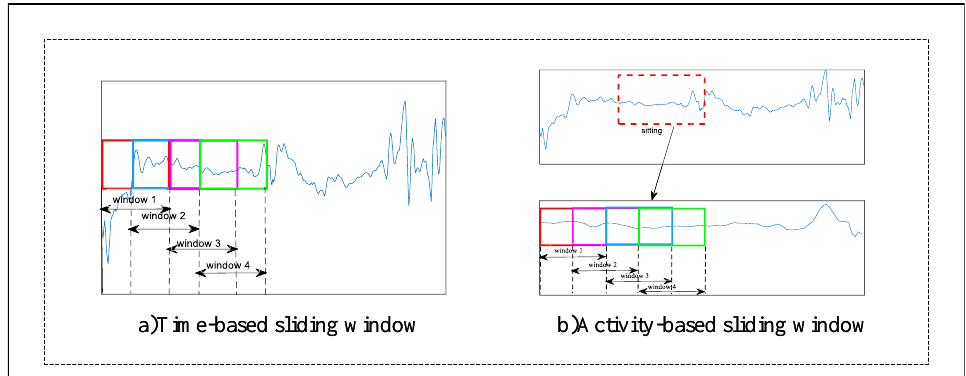
Figure 1. Two different segmentation methods of sliding window. ( a ) Time-based, and ( b )